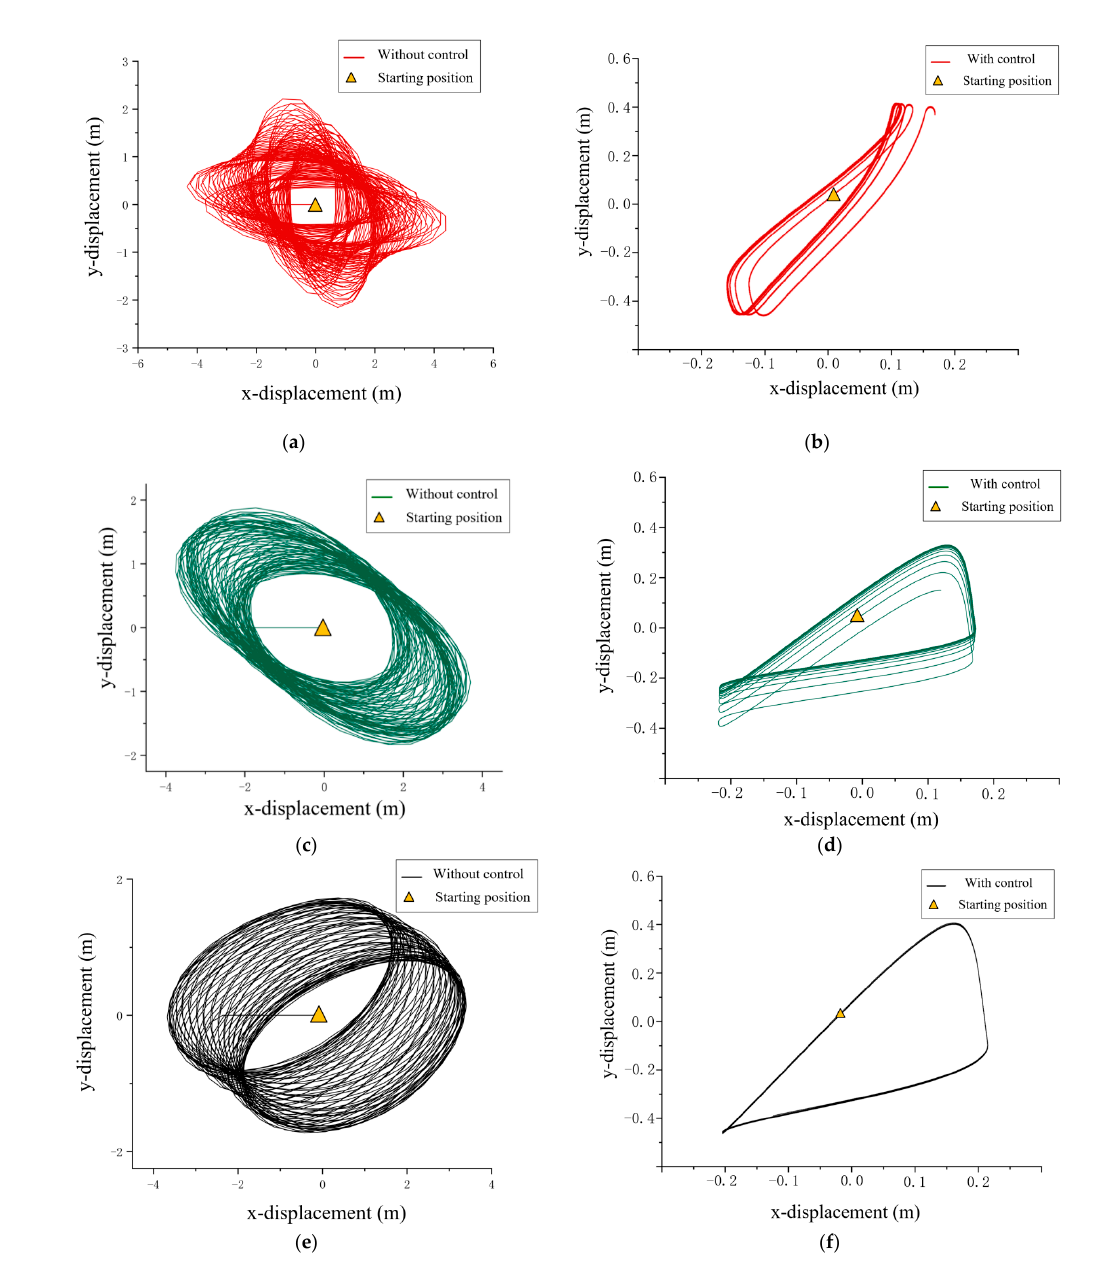
Figure 11. The dynamic response of TTAS under Condition 1. ( a ) The x, y displacement without control of the payload when the hoist cable is 0.6 m; ( b ) the x, y displacement with control of the payload when the hoist cable is 0.6 m; ( c ) the x, y displacement without control of the payload when the hoist cable is 1.2 m; ( d ) the x, y displacement with control of the payload when the hoist cable is 1.2 m; ( e ) the x, y displacement without control of the payload when the hoist cable is 1.8 m; ( f ) the x, y displacement with control of the payload when the hoist cable is 1.8 m.